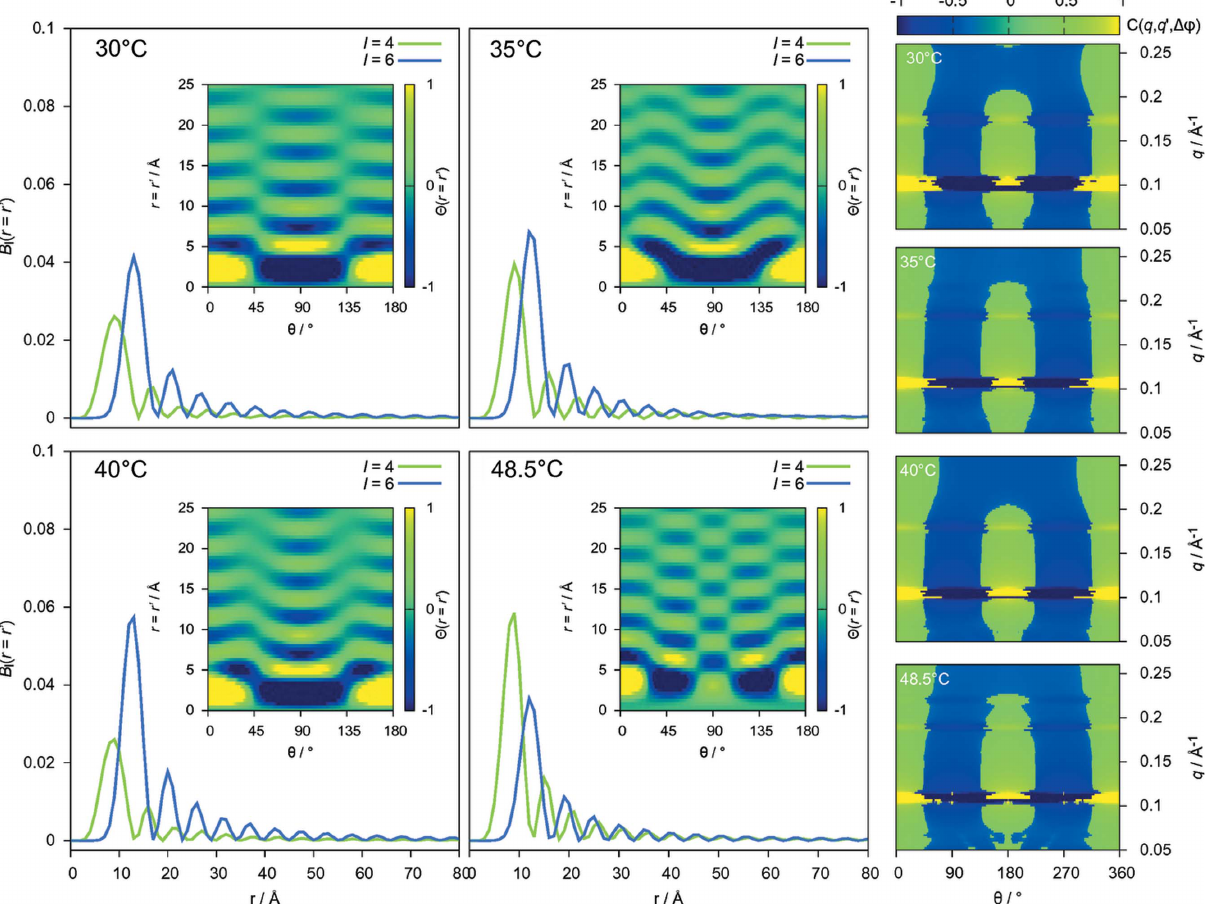
Figure 3 Temperature effects on real-space spherical harmonic coefficients. h B (cid:7) increasing temperature. The right-hand images show corresponding q -space q = q 0 correlation slices for the corresponding temperatures denoted on the